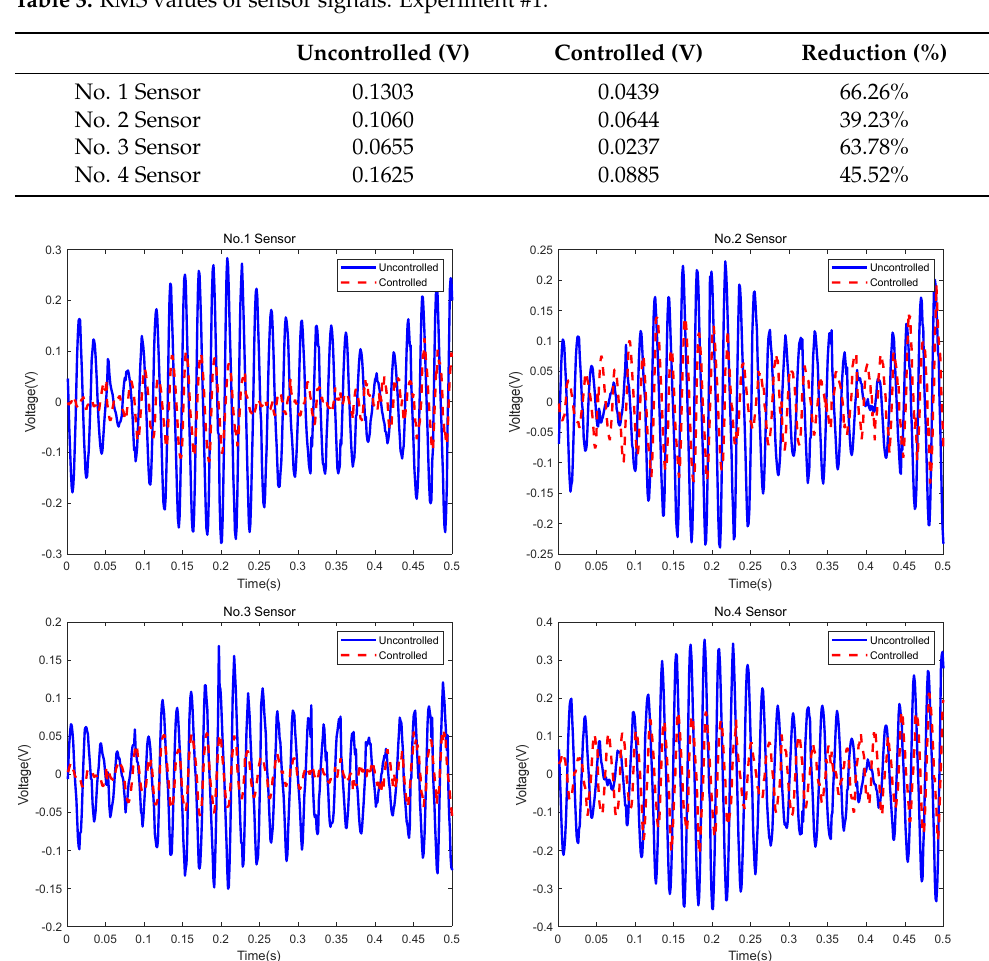
Table 3. RMS values of sensor signals: Experiment #1.